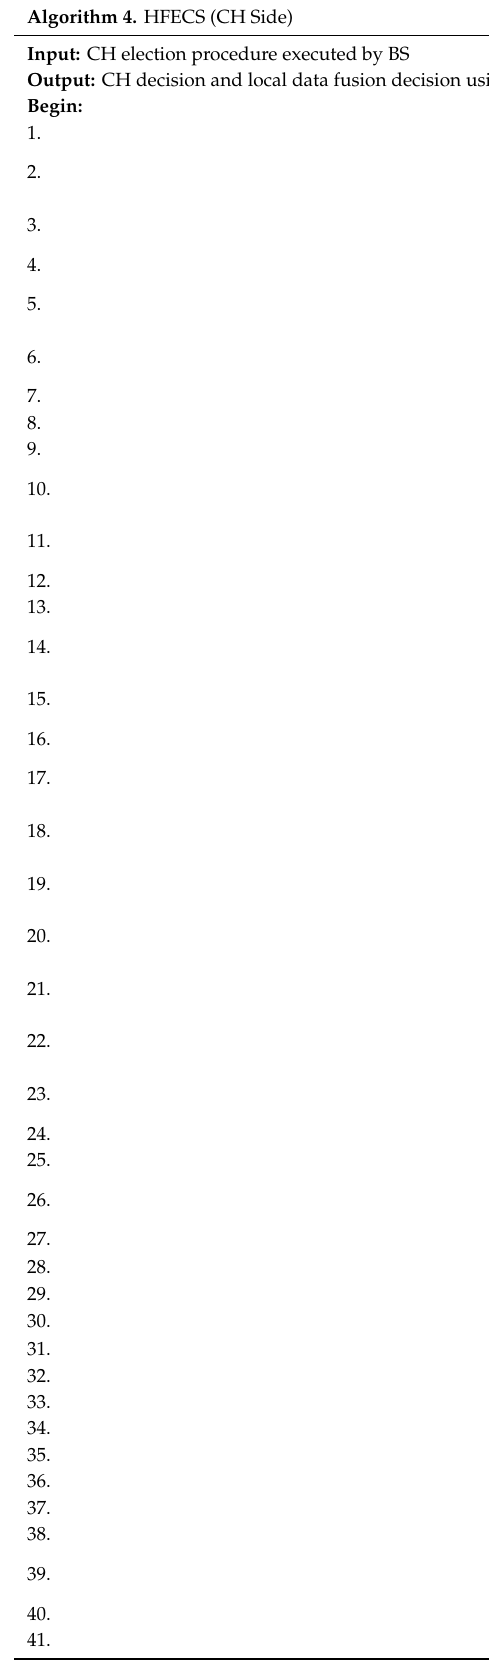
Algorithm 4. HFECS (CH